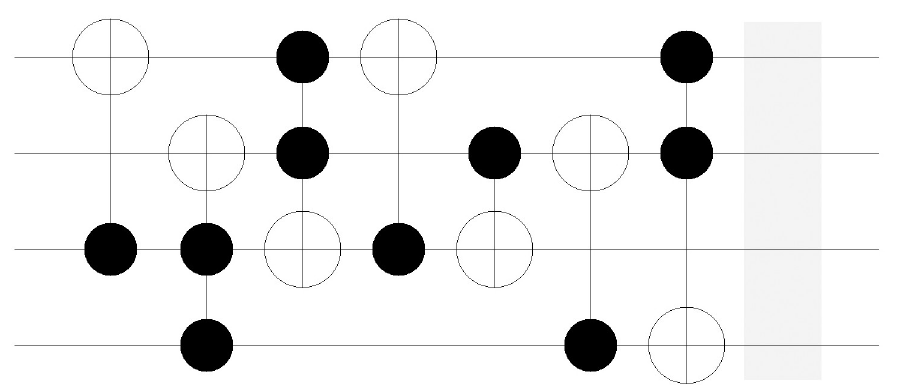
Fig 14. Resulting circuits of No. 18 mini_alu with varying N